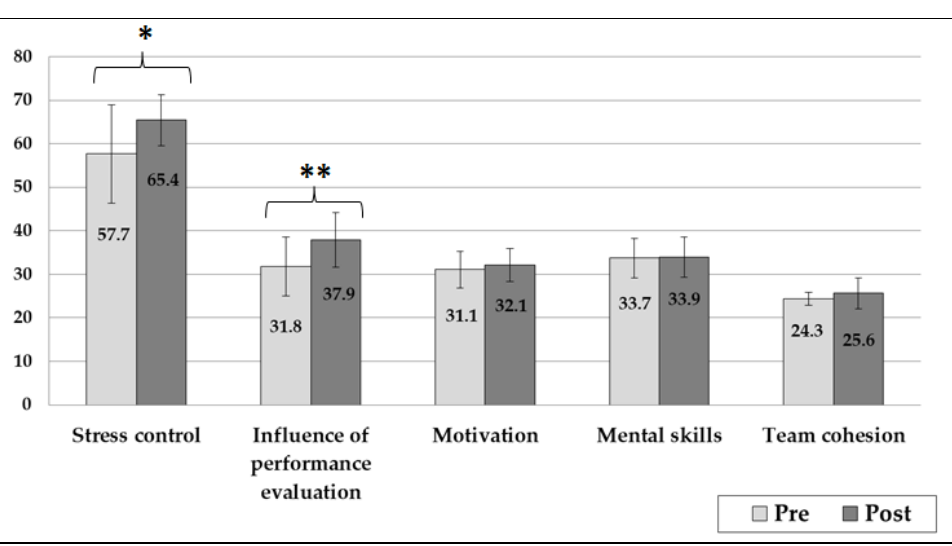
Table 2. Regression coefficients of the linear regression models for the variable championship (con- tinuous variables) adjusted by years of rowing experience. Variable